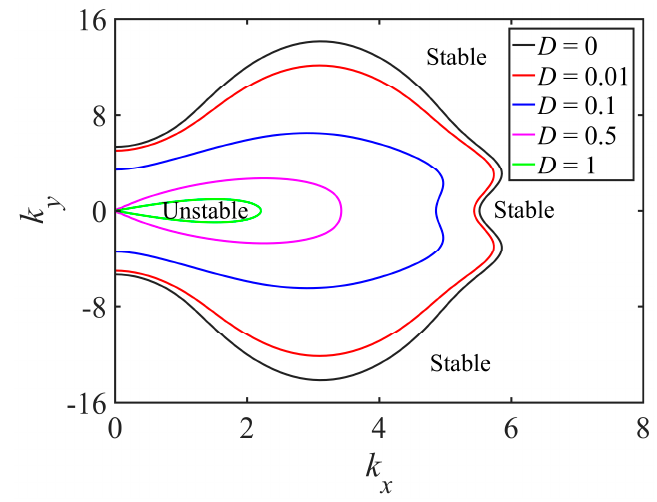
Figure 3. Marginal stability curves for different values of D .